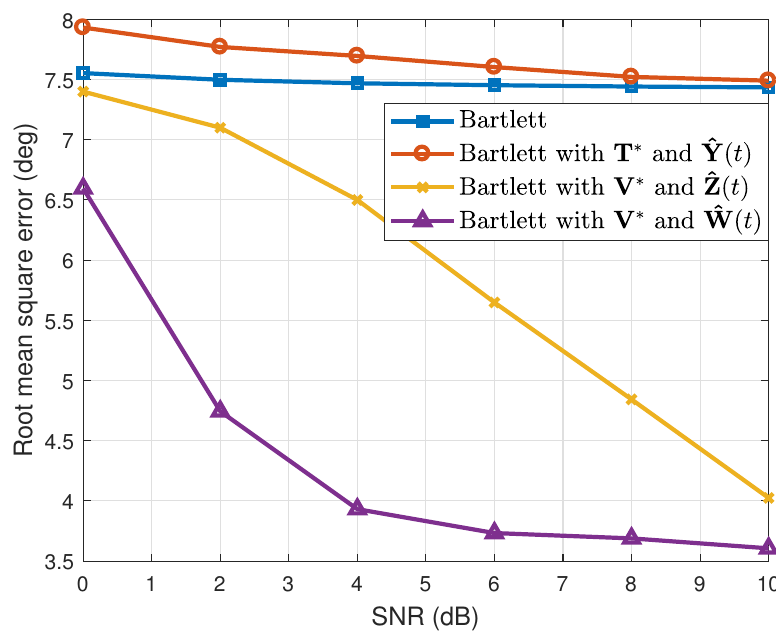
Figure 9. Root mean squared errors versus SNR ( N =